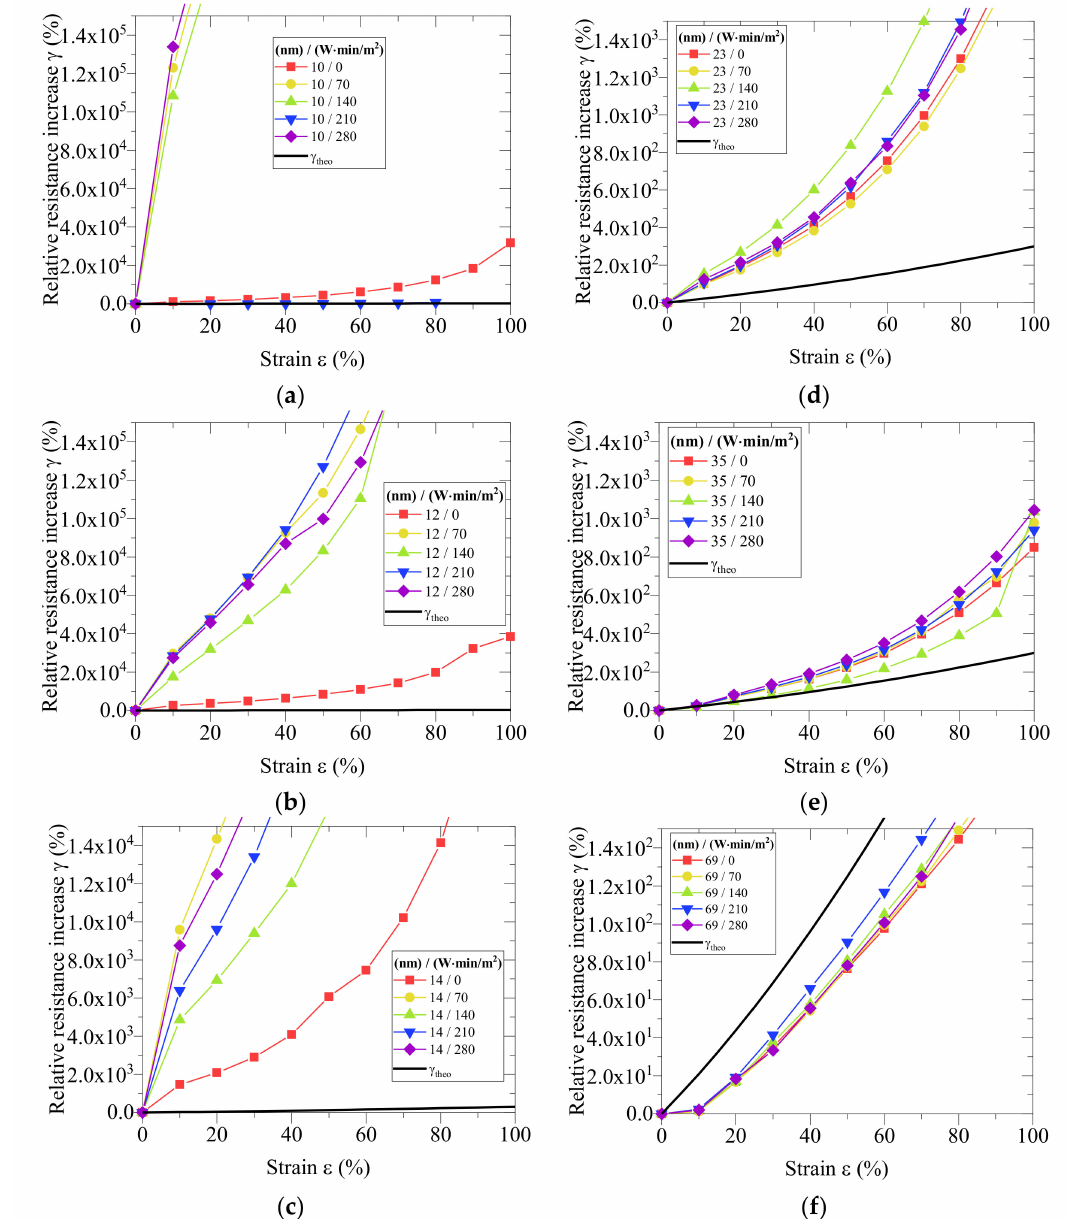
Figure 5. Increase in resistance under strain for PET films coated with aluminum layers of di ff erent thicknesses: ( a ) 10; ( b ) 12; ( c ) 14; ( d ) 23; ( e ) 35; and ( f ) 69 nm. Colored lines in each graph represent di ff erent corona dosages ranging from 0 to 240 W · min / m 2 as shown in the key. The y -axis scales vary by a factor of up to 10 3 . Each value is a mean of n = 5 measurements. Error bars are omitted and data points are joined by lines for visual